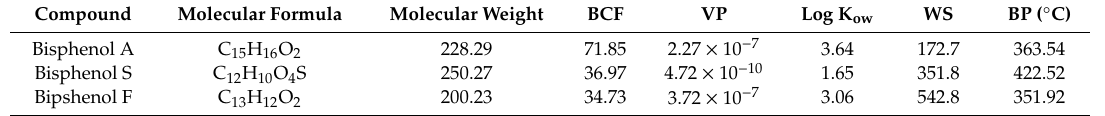
Table 4. Selected physicochemical properties of